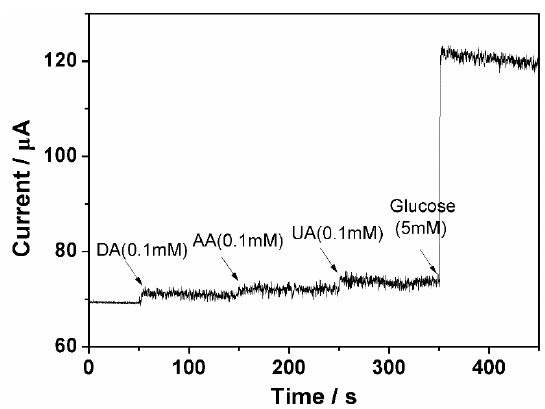
Figure 9. Amperometric response of the NiFe/GO/GCE electrode with interference by dopamine (DA), ascorbic acid (AA), and uric acid (UA) at physiological concentrations.